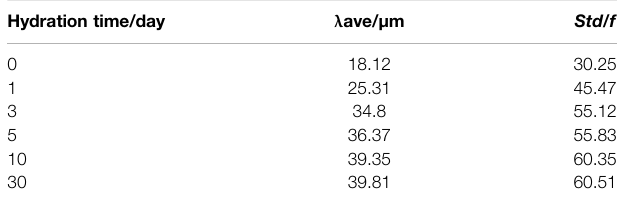
TABLE 1 | The diameter of PMs at different hydration times.